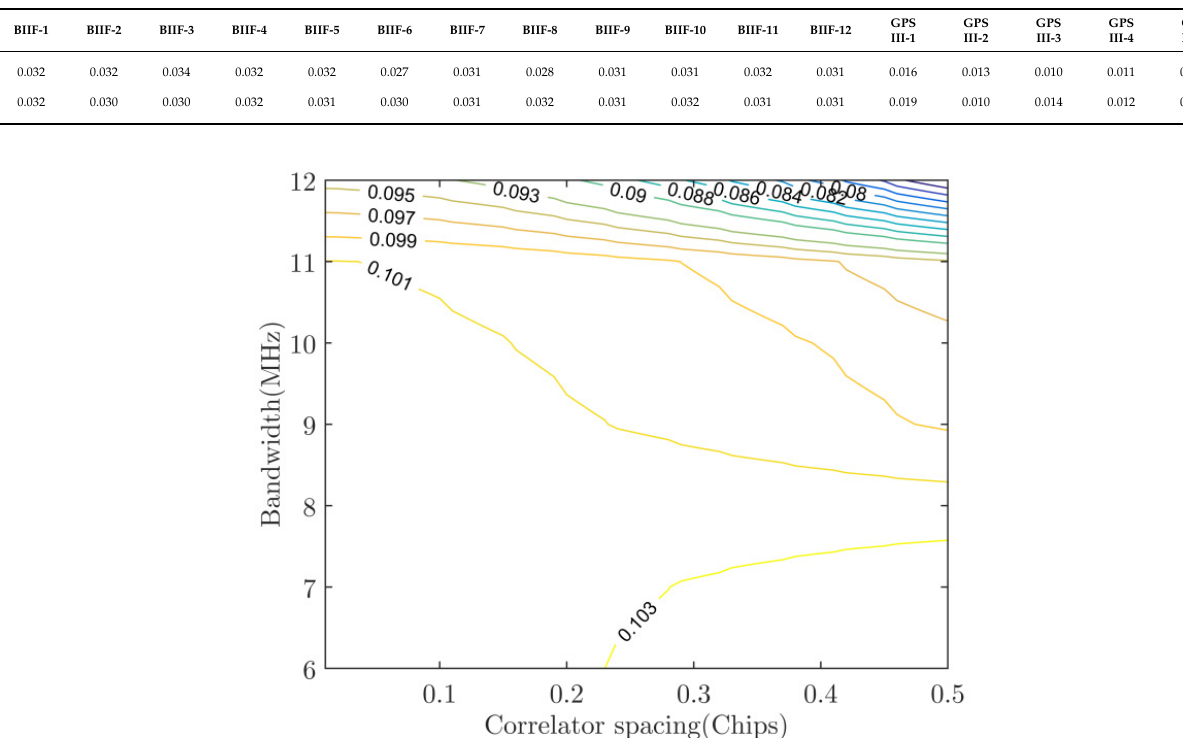
Figure 14. BIIF-5 L5-Cd SCB.